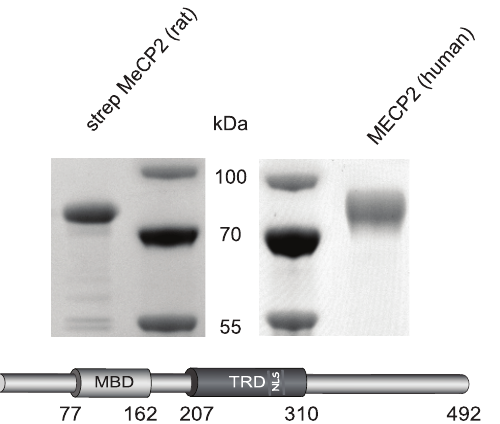
Figure 1. Antigen preparation. Purified strep-tagged MeCP2 (rat) and purified intein tagged MECP2 (human) were subjected to a SDS- PAGE and stained with Coomassie. The molecular weight markers are labeled in the middle. A schematic representation of the rat MeCP2 protein and its functional domains is shown below. MBD: methyl CpG binding domain; TRD: transcriptional repression domain; NLS: nuclear localization signal.